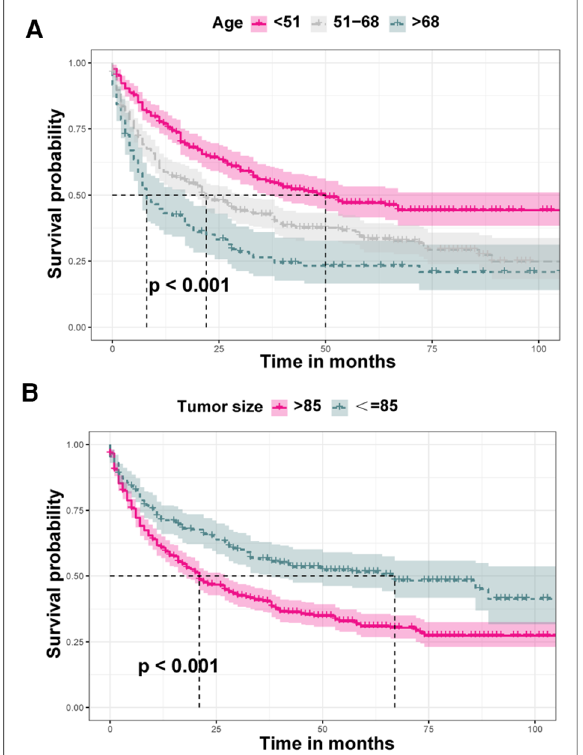
FIGURE 3 Comparison of diverse survival curves among various groups of age and tumor size. ( A ) Patients aged less than 51 years showed the highest survival rate, while patients aged above 68 years showed the worst survival rate, and the survival curve of patients aged 51 – 68 years was in the middle position; ( B ) survival probability of patients with tumors larger than 85 mm was lower that of those with tumors less than or equal to 85